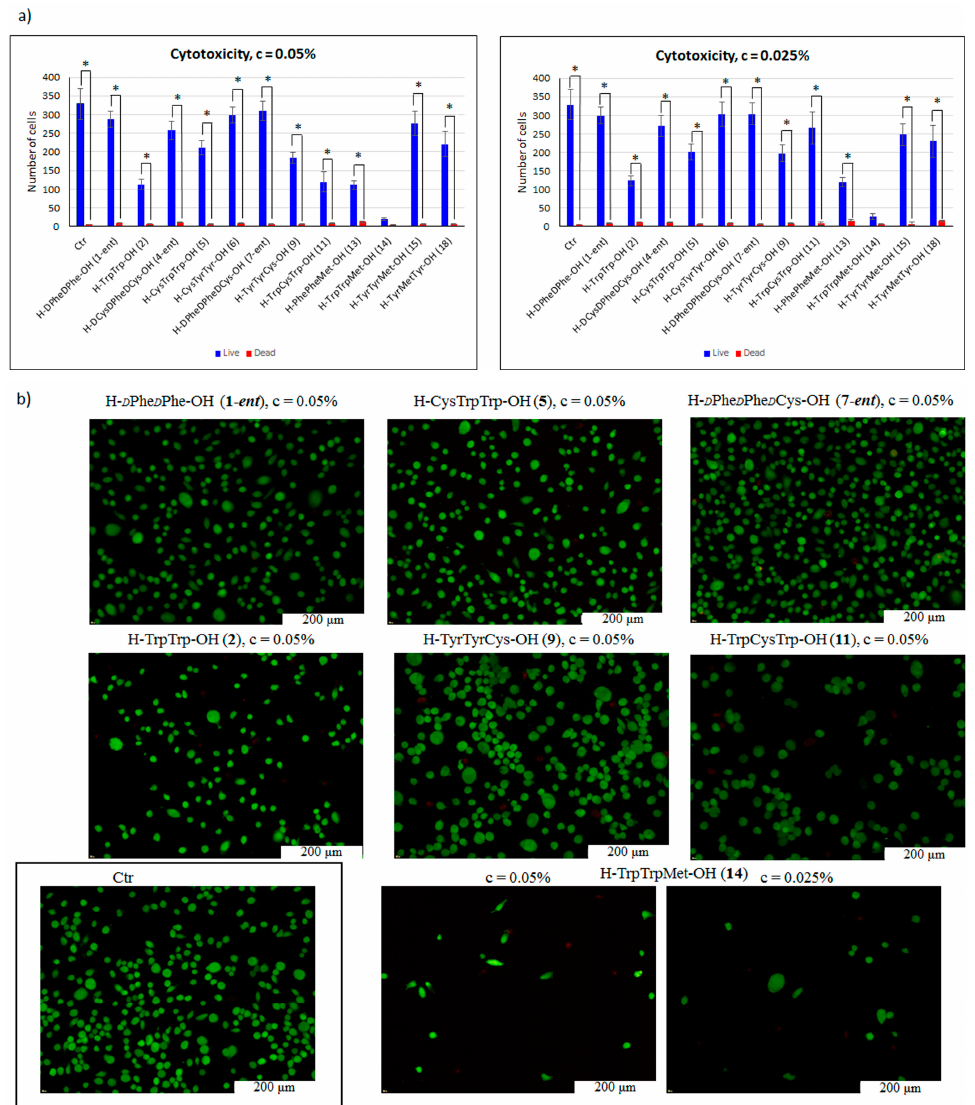
Figure 9. ( a ) Cytotoxicity of selected peptides at two different concentrations (c = 0.05% and 0.025%), determined for the endothelial cell line EA.hy 926 using the live/dead assay, statistically significant results are marked with star; ( b ) two fluorescent dyes: Calcein AM (green color for live cells) and ethidium homodimer-1 (EthD-1, stains dead cells red). Additional statistical data are presented in Supporting Materials.